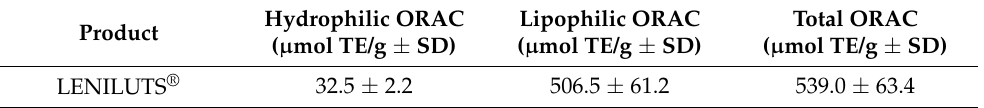
Table 1. Hydrophilic, lipophilic, and total ORAC values of the product LENILUTS ® , expressed